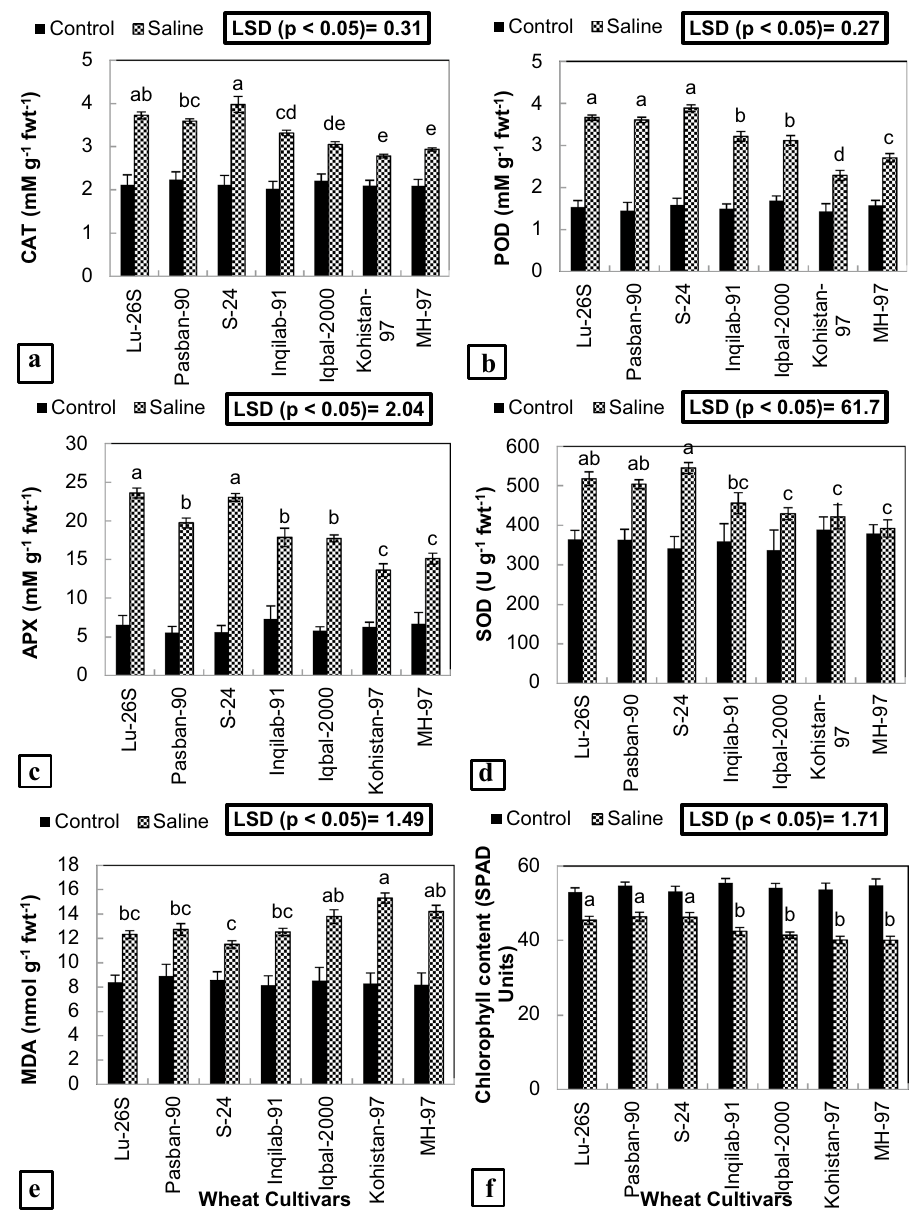
Figure 3. Concentration of antioxidant enzymes, MDA and chlorophyll content (SPAD values) of seven selected salt tolerant and sensitive wheat cultivars subjected to 0 or 150 mM NaCl stress at adult stage. Different letters represent significant differences among the cultivars at ( p < 0.05) by LSD test. CAT = Catalase, POD = Peroxidase, APX = Ascorbate peroxidase, SOD = Superoxide dismutase, MDA = Malondialdehyde. ( a ) CAT activity, ( b ) POD activity, ( c ) APX activity, ( d ) SOD activity, ( e ) MDA content and ( f ) Chlorophyll